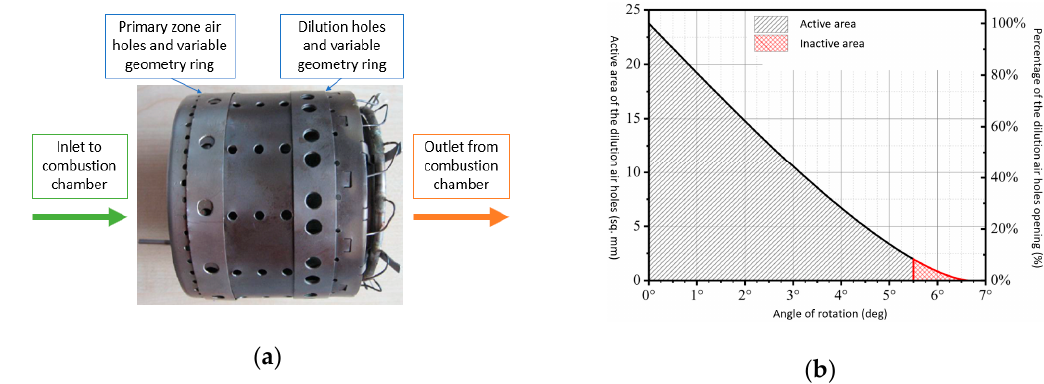
Figure 3. Proposed variable geometry combustion chamber: ( a ) system overview; ( b ) chart showing air hole area related to percentage of original hole opening.